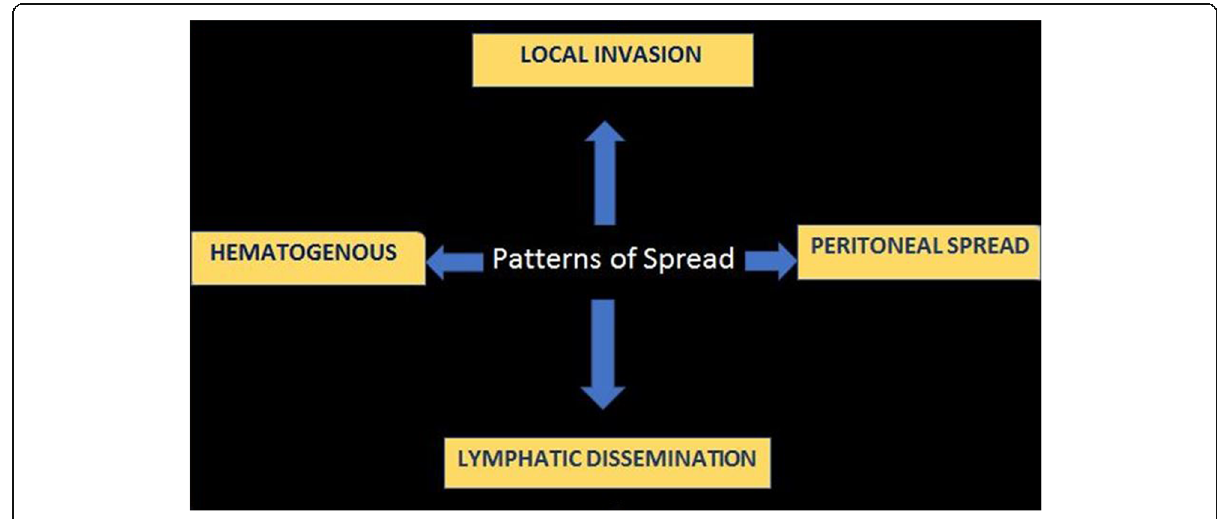
Fig. 1 Patterns of spread of gall bladder